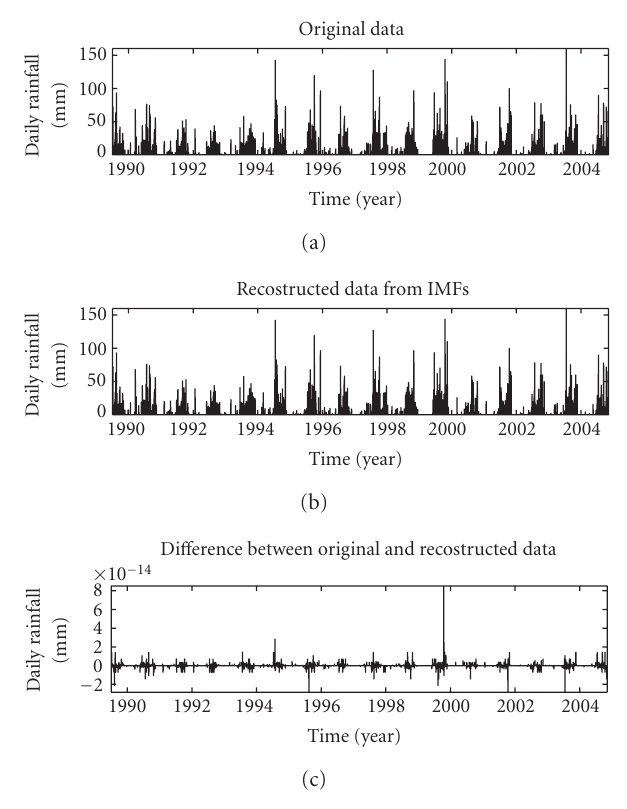
Figure 3.7. The reconstructed rainfall data and the error with the original